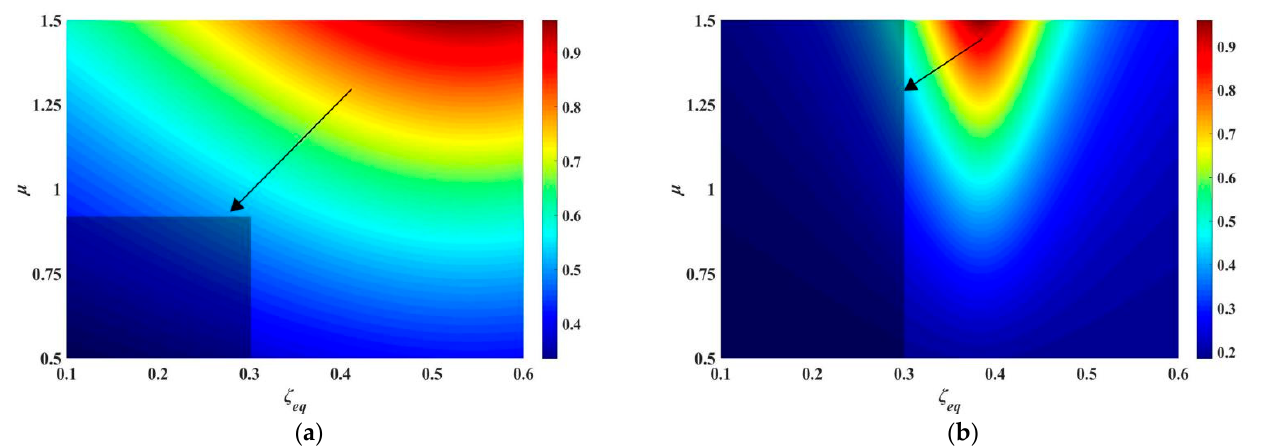
Figure 10. Contour plot of γ SF of HB–1 : ( a ) κ = 0.05; ( b ) κ = 0.1 .